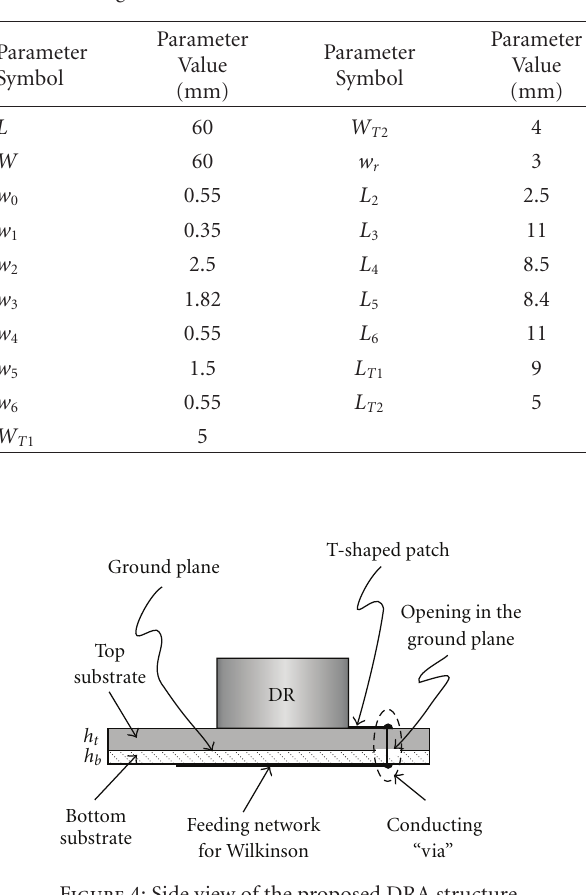
Table 1: Design parameters of the proposed direction-finding structure using dielectric resonator.